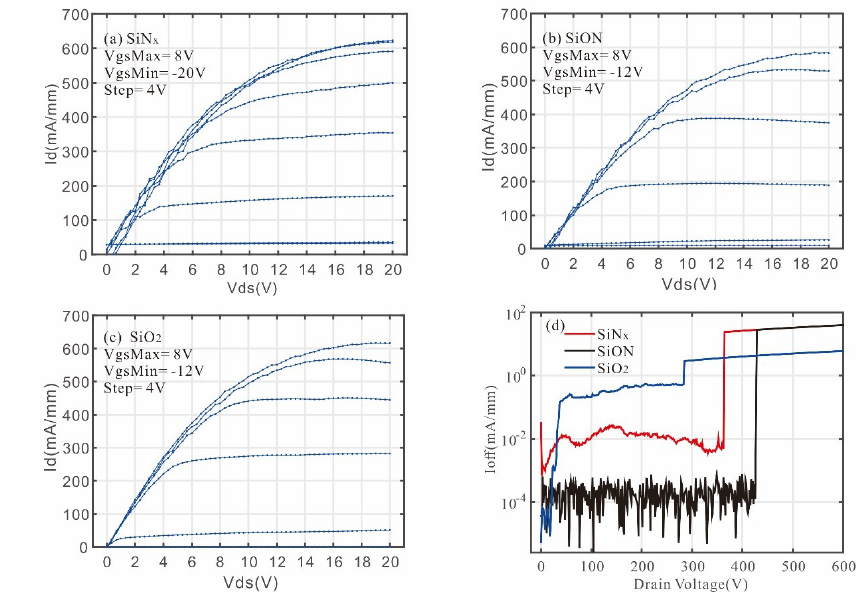
Figure 2. Output characteristic of ( a ) SiNx MIS-HEMT, ( b )SiON MIS-HEMT, and ( c ) SiO 2 MIS-HEMT. ( d ) off-state breakdown characteristic of the three samples, measured at V gs = −18 V. Table 2 . Selected properties of SiN x , SiON, and SiO 2 MIS-HEMT.